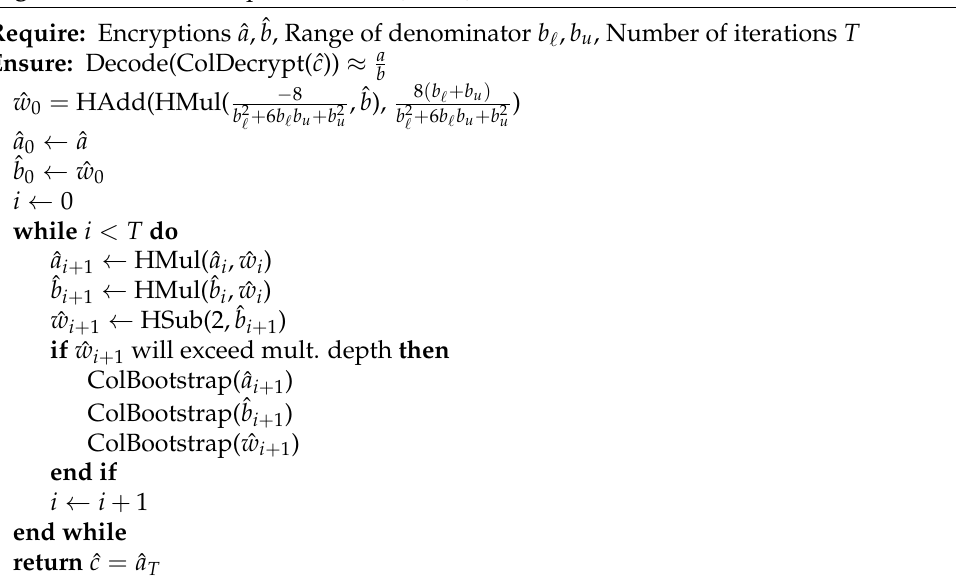
Algorithm 2 Homomorphic division (HDiv)